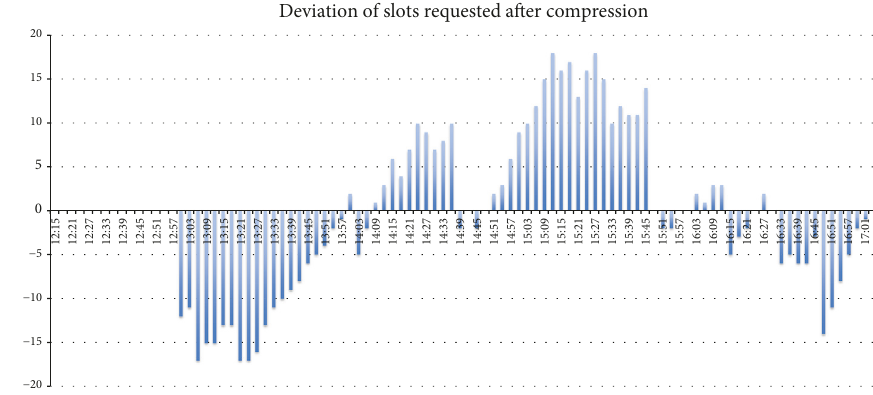
Figure 12: Deviation of slots requested after compression (case study 1). Table 4: Effect of sequence compression on the AUs actual costs (case study